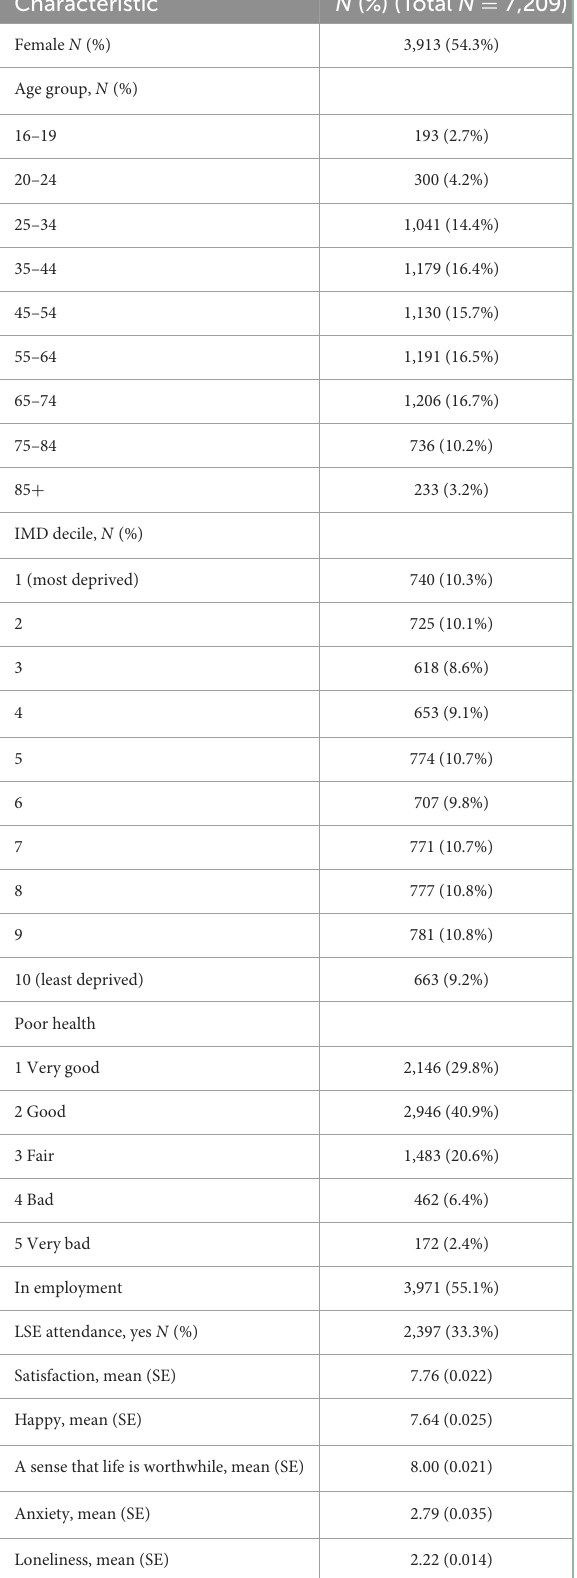
TABLE 1 Participant